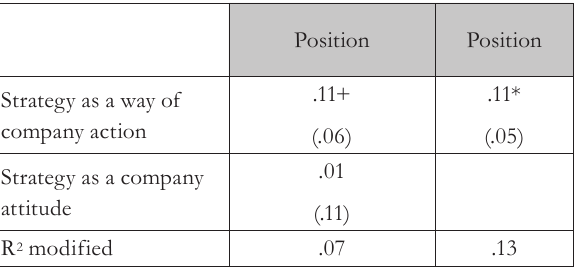
Tab. 2 An impact of environment and strategy on a company